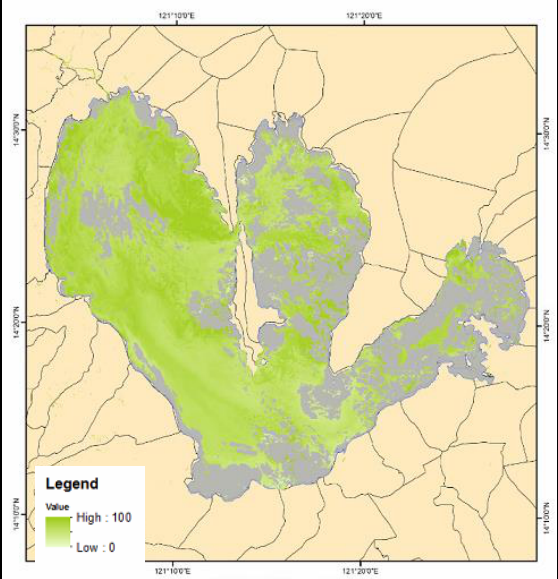
Figure 9. BOMBER tool derived CDOM Map of Oct 16, 2018